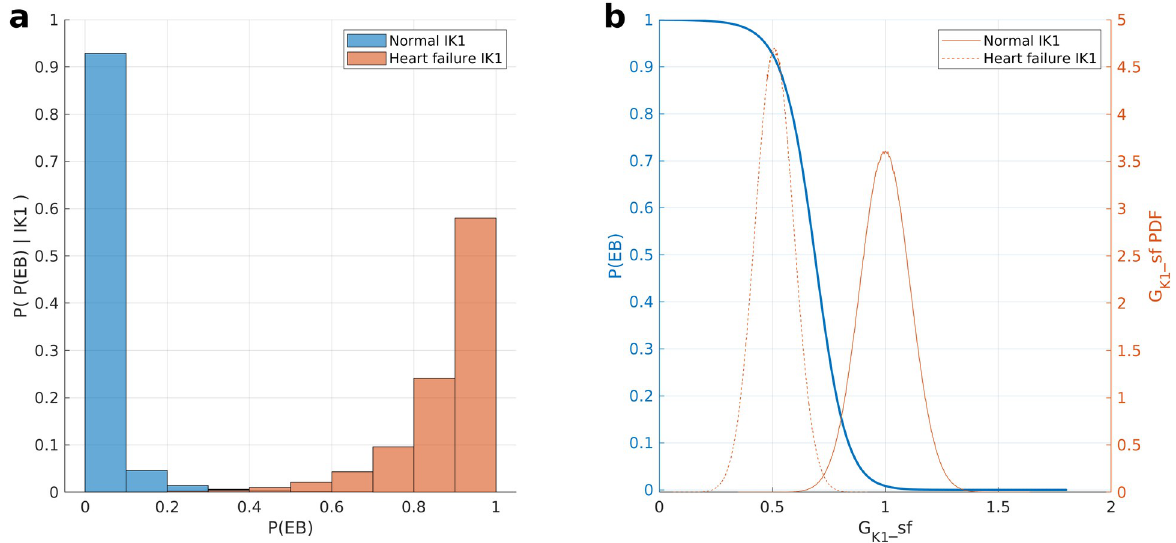
Fig 4. Effect of G K1 _sf uncertainty on P(EB). (A) Distributions of P(EB) for normal G K1 _sf (blue) and HF G K1 _sf (red). (B). MC curve (blue) shows the relationship of G K1 _sf and P(EB) for the LRM. G K1 _sf PDFs for normal (solid red line) and HF (dashed red line).